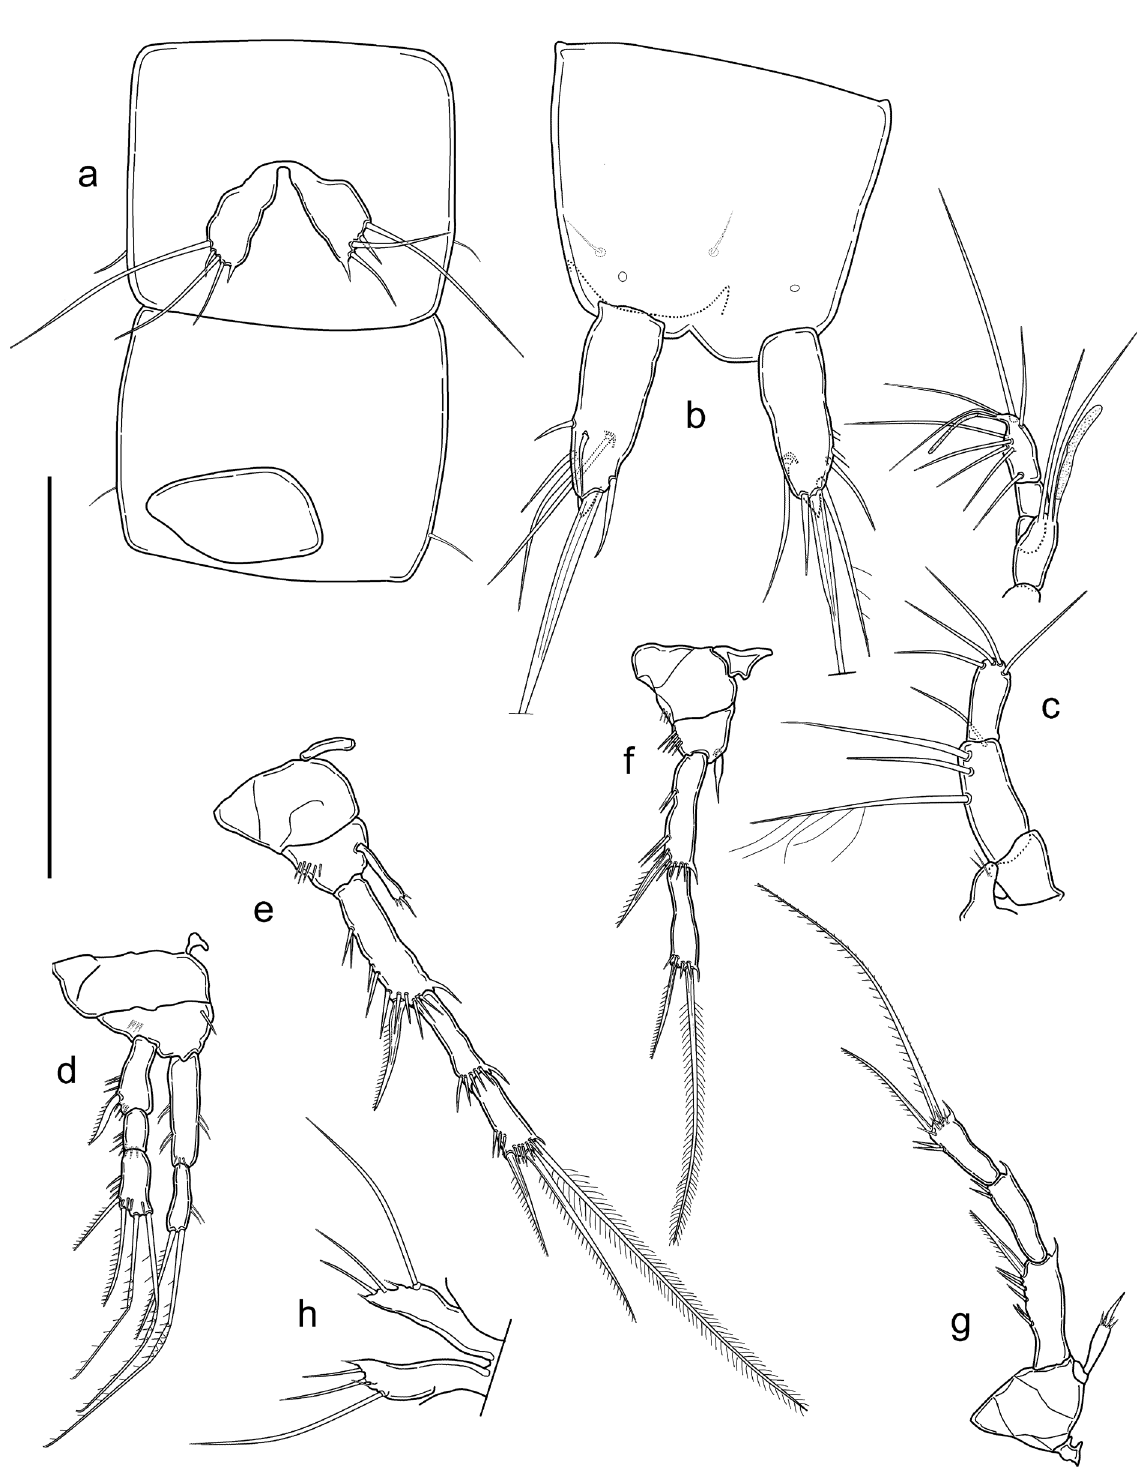
Fig. 11. Stammericaris vincentimariae Bruno & Cottarelli sp. nov. (NHMUK). a . ♂, P5, P6, first and second urosomites, ventral view. b . ♀, anal somite, anal operculum and caudal rami, ventral view. c . ♀, rostrum and A1. d . ♀, P1, posterior view. e . ♀, P2, anterior view. f . ♀, P3, anterior view. g . ♀, P4, anterior view. h . ♀, P5. Scale bar: 50